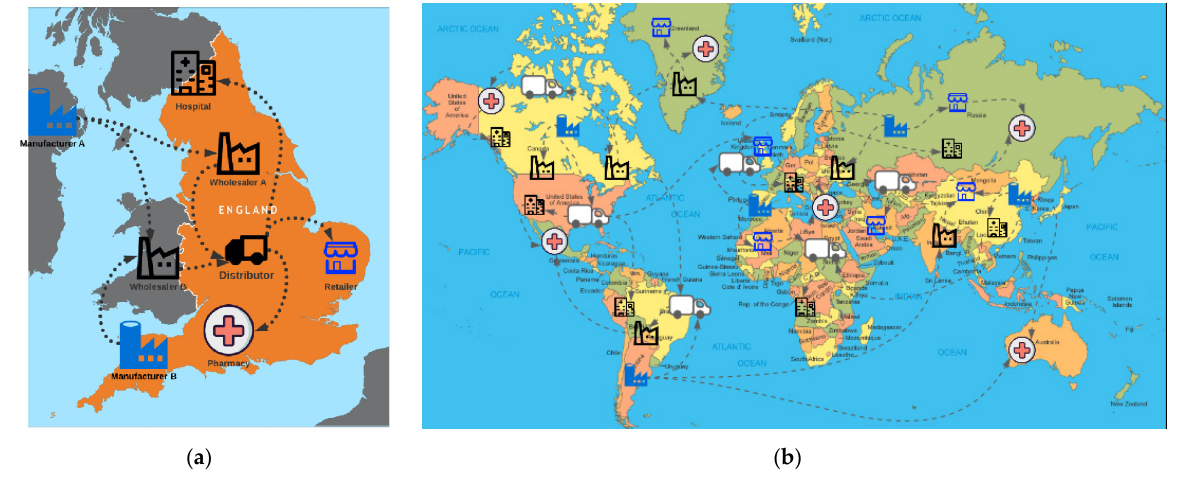
Figure 2. Pharmaceutical distribution system examples. ( a ) Distribution of medicine in the U.K.; ( b ) distribution of medicine worldwide.